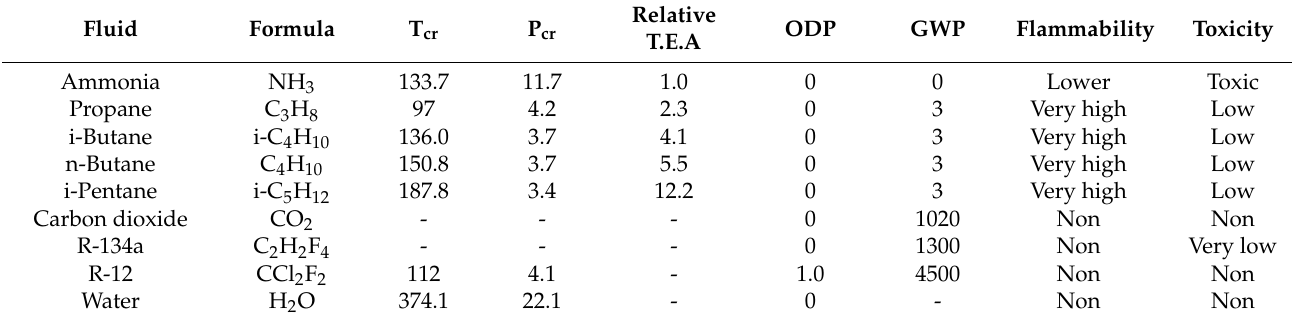
Table 1. Properties of some candidate working fluids for